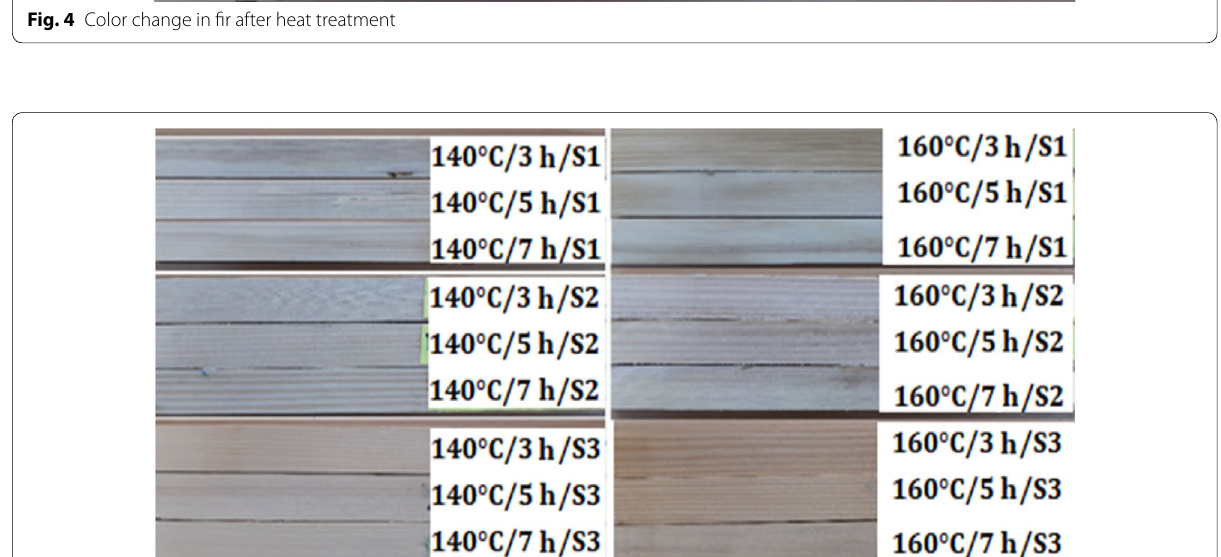
Fig. 5 Heat-treated fir samples after bleaching